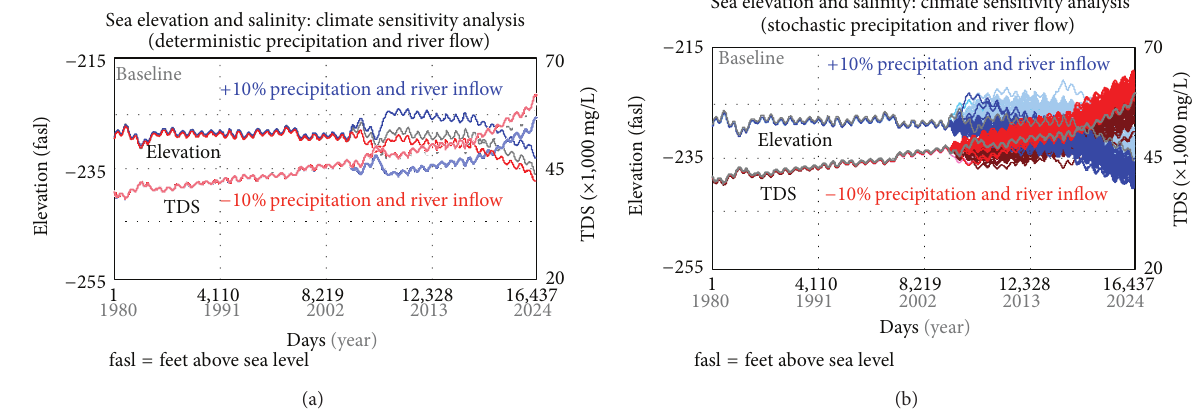
Figure 5: Salton Sea Stochastic Simulation Model (S 4 M) climate sensitivity analysis: (a) climate sensitivity analysis ( ± 10% historic) using deterministic driving variables (100 replicates) and (b) climate sensitivity analysis ( ± 10% historic) using stochastic (100 replicates) driving